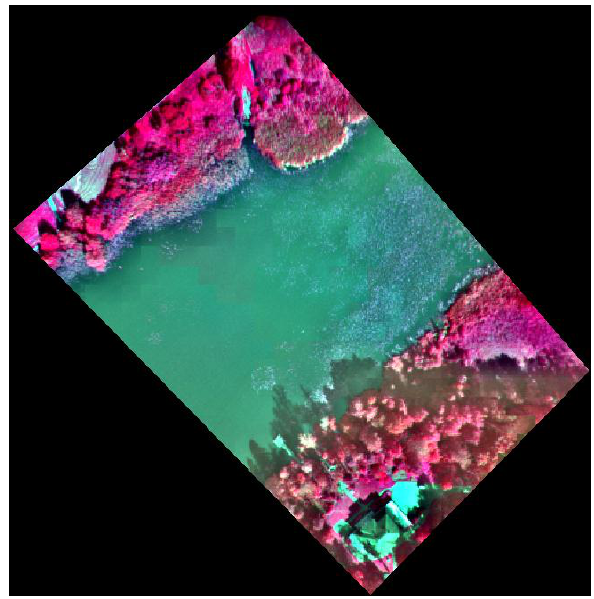
Figure 8. A UAV image mosaic of size of 140 m by 250 m and with a 0.20 m GSD. Georeferencing based on: © The National Land Survey of Finland, Colour orthophoto and Elevation model 10 m, 01/2013, http://www.maanmittauslaitos.fi/en/NLS_open_data _licence_version1_20120501 3.4 Comparison of campaigns from UAV and MAV It is not feasible to compare image quality from MAV and UAV flights. This is due to the fact that imaging conditions were much poorer in the flight campaign with the MAV. This appeared both as lower level irradiance as well as lower atmospheric